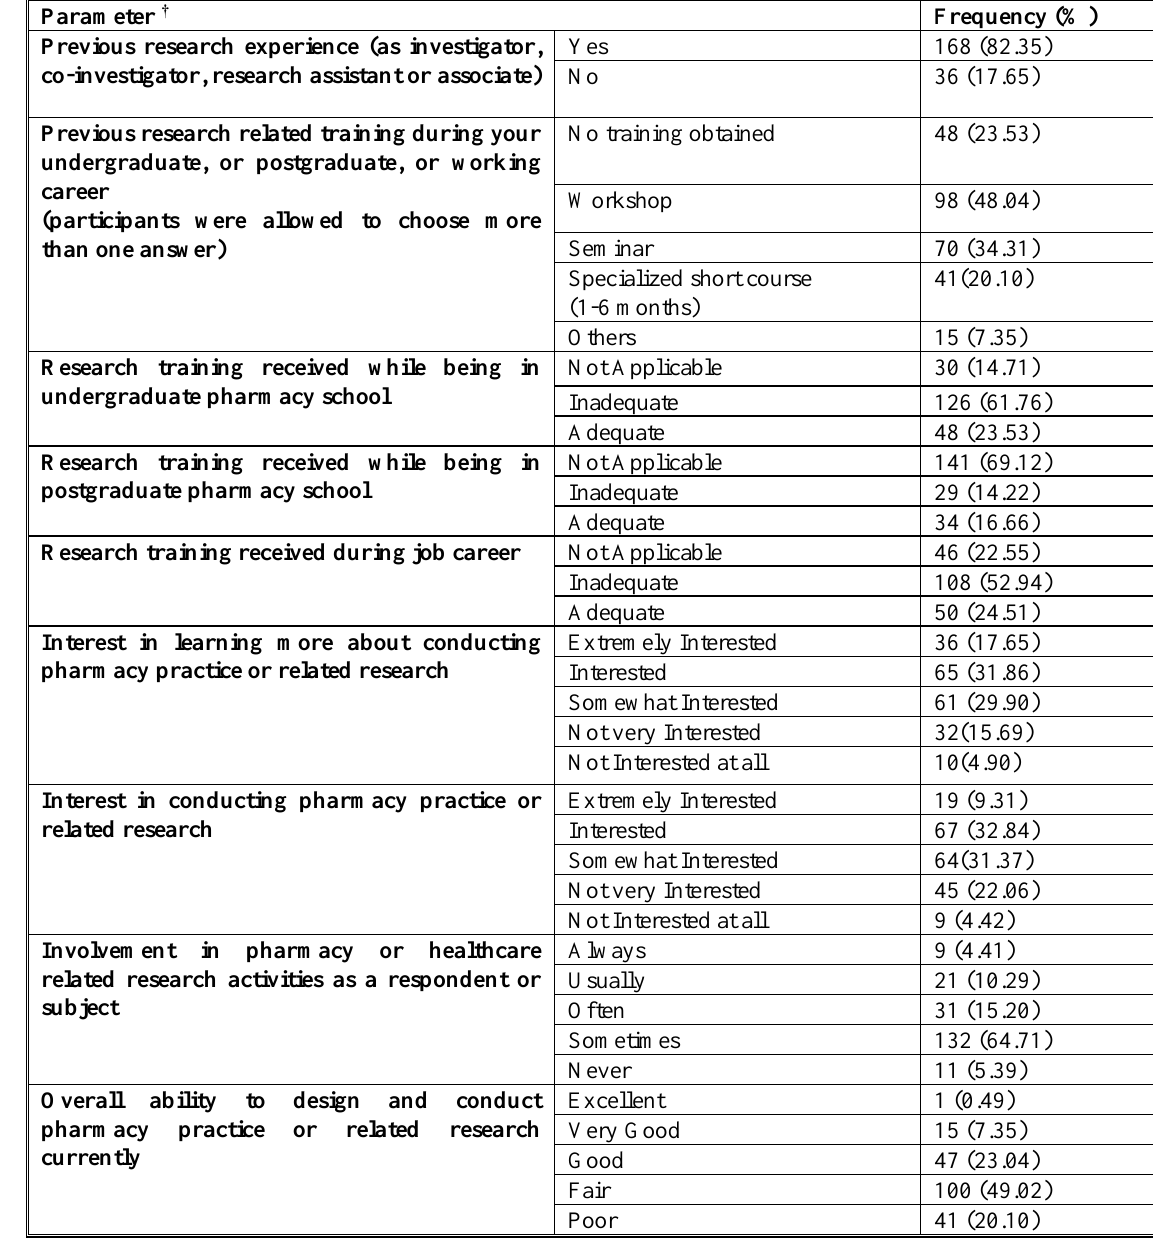
Table 2 . Research background and interests of Malaysian hospital pharmacists who responded to the survey (n= 226) Parameter